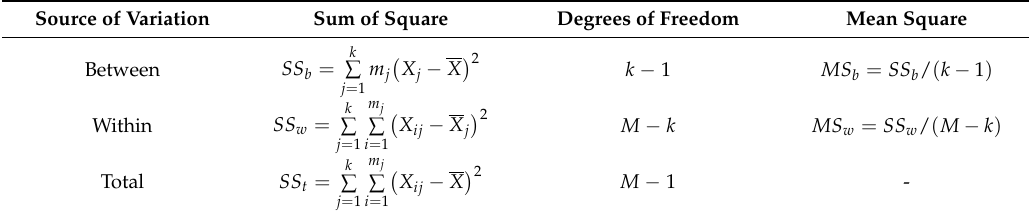
Table 1. Computation table for analysis of variance test. SS : Sum of square; DF : degrees of freedom and MS : mean